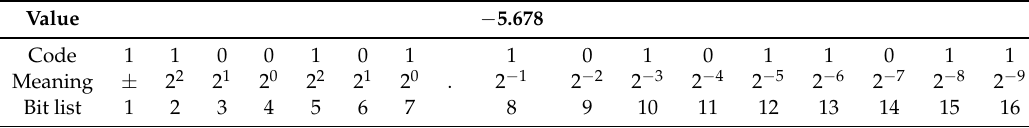
Table 1. An example for the fixed point representation. −